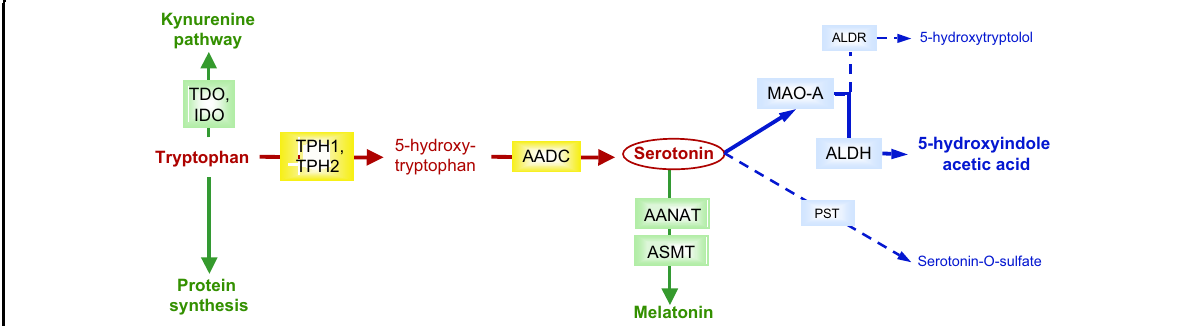
Fig. 1 Serotonin metabolism. Serotonin is synthesized from tryptophan (red steps) by tryptophan hydroxylases (TPH1, non-neuronal, and TPH2, neuronal) and aromatic amino-acids decarboxylase (AADC). Of the two catabolic pathways (blue steps), the major one sequentially involves monoamine oxidase A (MAO-A) and aldehyde dehydrogenase (ALDH) or reductase (ALDR). Sulfoconjugation by phenol sulfotransferases (PST) is a quantitatively minor pathway. Alternatively, tryptophan can enter the kynurenine pathway after oxidation by indoleamine-2,3-dioxygenase (IDO) or tryptophan 2,3-dioxygenase (TDO), or serotonin be converted into melatonin by arylalkylamine N-acetyltransferase (AANAT) and acetylserotonin methyltransferase